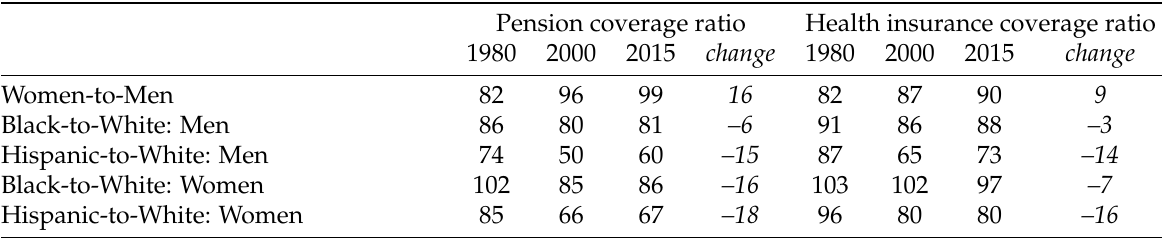
Table 1: Women-to-men, black-to-white, and Hispanic-to-white benefit coverage ratios (percentages), 1980 and